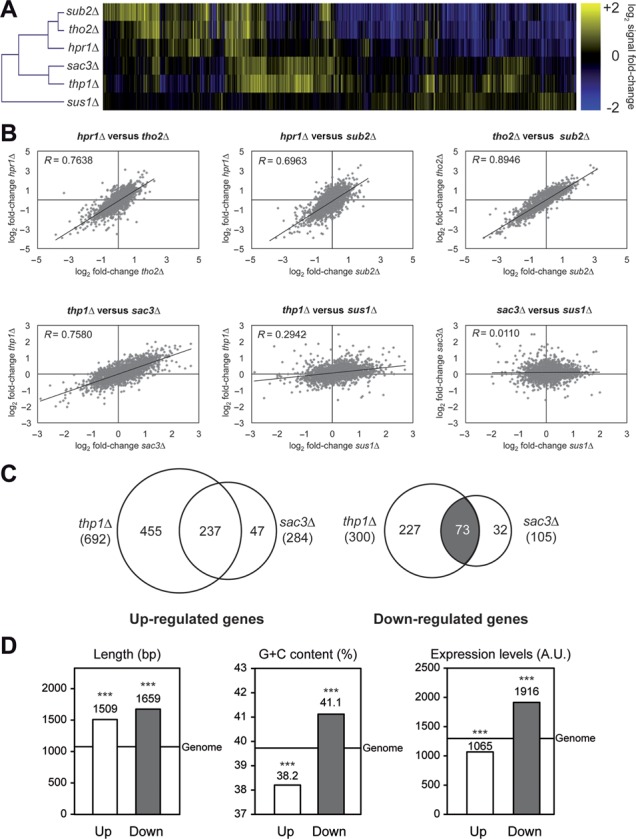
Microarray expression analysis of genes affected by THO, Sub2 and THSC/TREX-2 mutations. (A) Clustering of the expression profiles of THO–Sub2 and Thp1–Sac3 mutants. Heat-map of the 50% of genes with major log2 signal fold-change in THO, Sub2 and THSC/TREX-2 mutants compared to wild type is shown. (B) Correlation analysis between the expression profiles of THO–Sub2 and THSC/TREX-2 mutants. Scatter plots showing correlation among the log2 signal fold-change of THO–Sub2 (top) and THSC/TREX-2 (bottom) mutants. A linear regression line and the Pearson's R correlation coefficient are plotted per graph. (C) Overlap between de-regulated genes in thp1Δ and sac3Δ mutants. Venn diagrams representing the genes whose expression is significantly changed (P < 0.05, fold-change > 1.5) in thp1Δ and sac3Δ cells. The complete list of genes can be found in the Supplementary Dataset II. (D) Functional and structural features of the de-regulated genes in thp1Δ and sac3Δ mutants. Statistical analysis of length, G+C content and model-based expression levels for genes whose expression levels are coincidently affected in thp1Δ and sac3Δ cells. Median values are shown and a line represents the genome median. ***, P < 0.001 (Mann–Whitney's U-test) as compared to the genome median. Genes showing expression levels below the median of the meiotic genes in our experiments in at least 50% of the samples were removed from the comparison.